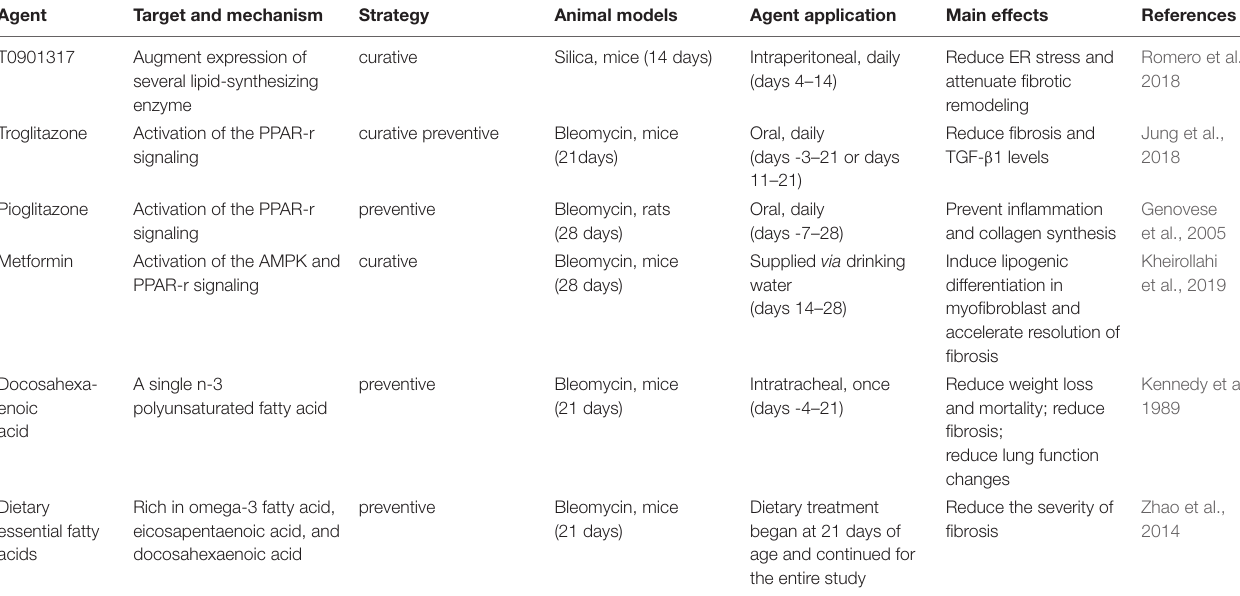
Agent Target and mechanism Strategy Animal models Agent